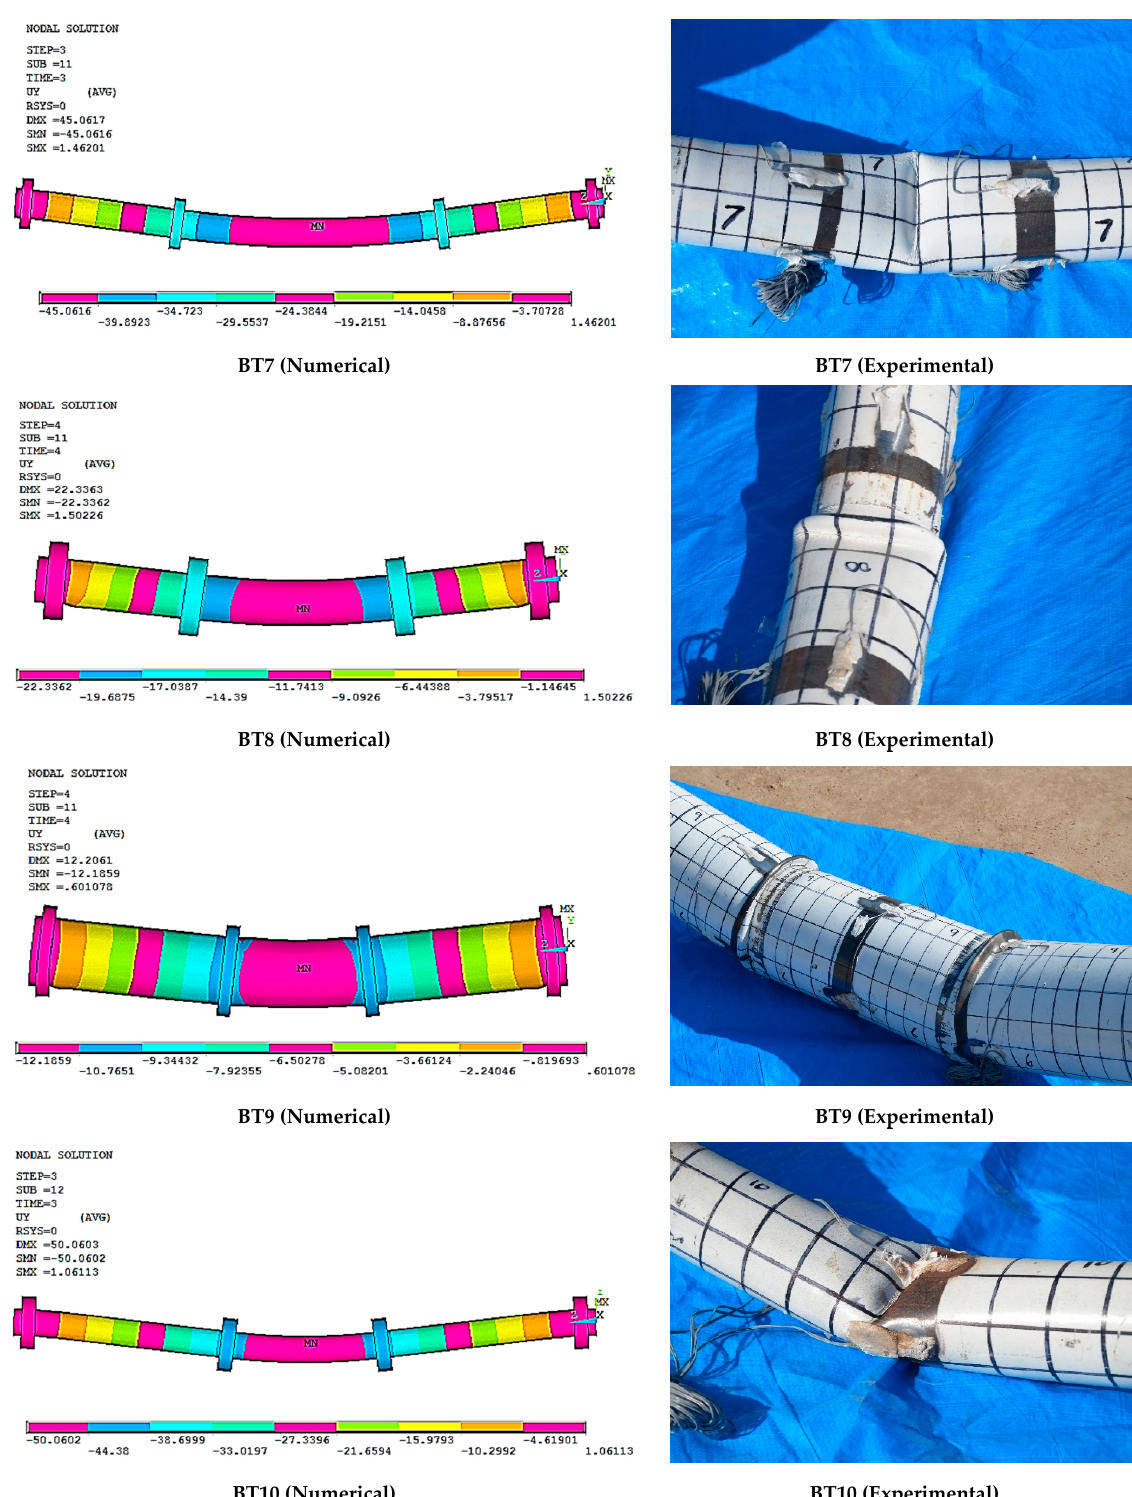
Figure 9. The displacement of specimens BT1 to BT10.